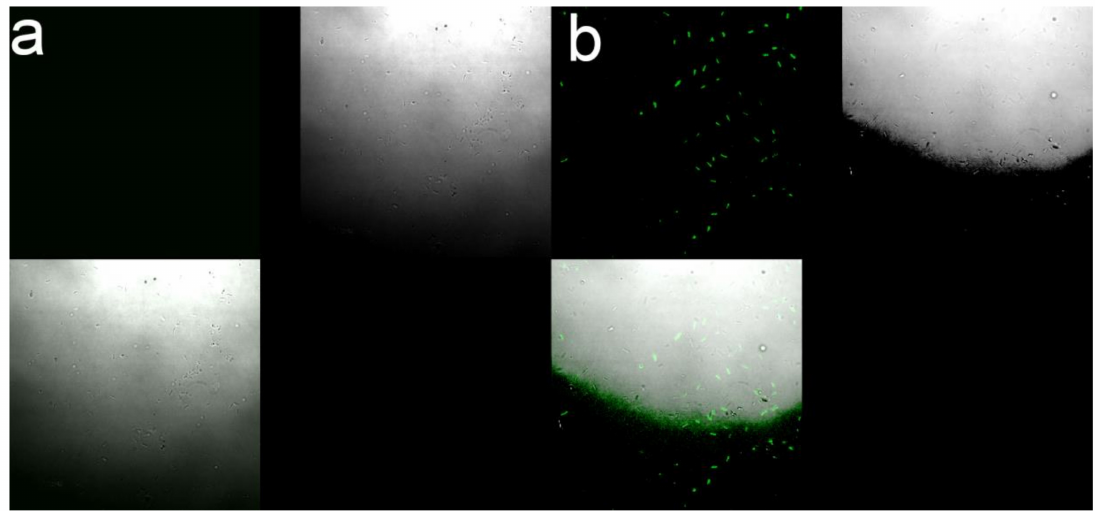
Figure 9. Bacterial fluorescence image treated by H2DCFDA. ( a ) Control group; ( b ) treated by